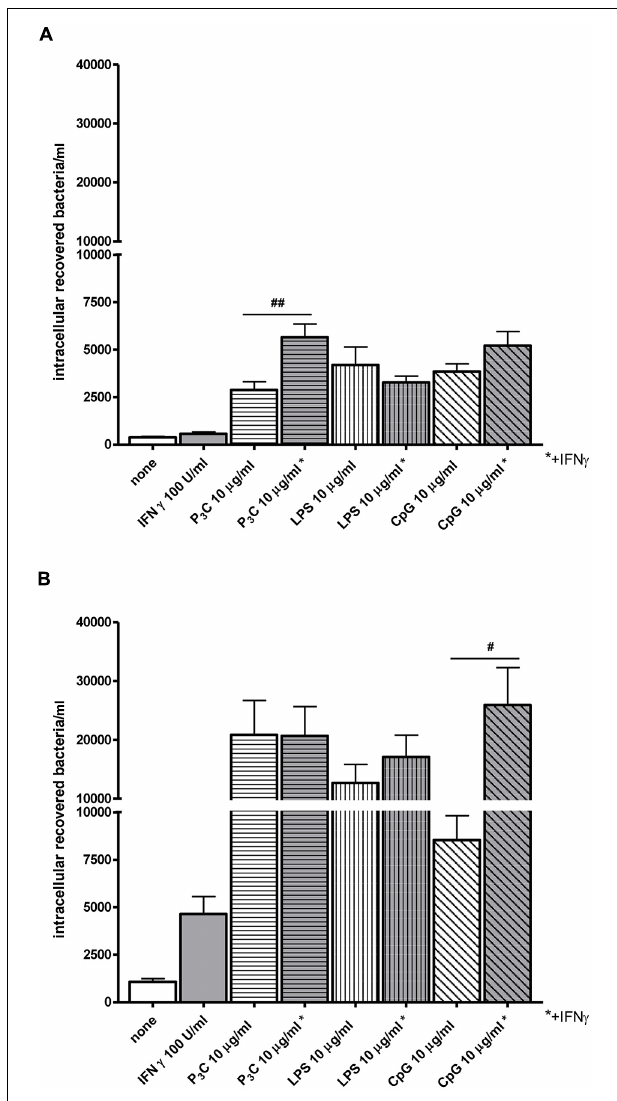
FIGURE 4 | Effect of interferon γ (IFN γ ) on bacterial phagocytosis by Toll-like receptor-stimulated primary microglia. (A) 30 min and (B) 90 min of phagocytosis of E. coli DH5 α by microglial cells after 24 h of stimulation with theTLR agonists: 0.1 μ g/ml Pam 3 CSK 4 (P3C), 0.01 μ g/ml LPS and 1 μ g/ml CpG alone or in combination with 100 U/ml IFN γ . After stimulation, cells were washed and bacteria were added for different time periods (30 and 90 min).Then, gentamicin (200 μ g/ml) was added for 1 h to kill extracellular bacteria.Thereafter, bacteria were lysed in 0.1 ml of distilled water.The number of ingested bacteria was determined by quantitative plating of the cell lysates after the different incubation intervals. Data are shown as recovered bacteria (CFU) per well [mean ± SEM (error bars)]. Data were analyzed using one-way ANOVA followed by Bonferroni’s multiple comparison test ( # P < 0.05; ## P < 0.01; Sandra Ribes, unpublished